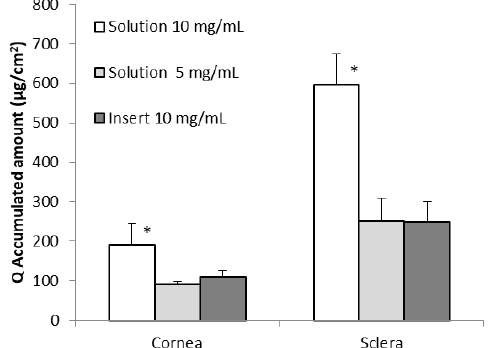
Figure 5. Accumulated amount of GSH in the receptor compartment after 3 h of experiment (Q, μg/cm 2 ) obtained from samples of ex-vivo trans-corneal and trans-scleral diffusion studies performed with different formulations. (Mean ± SD; n ≥ 3) * p < 0.05.